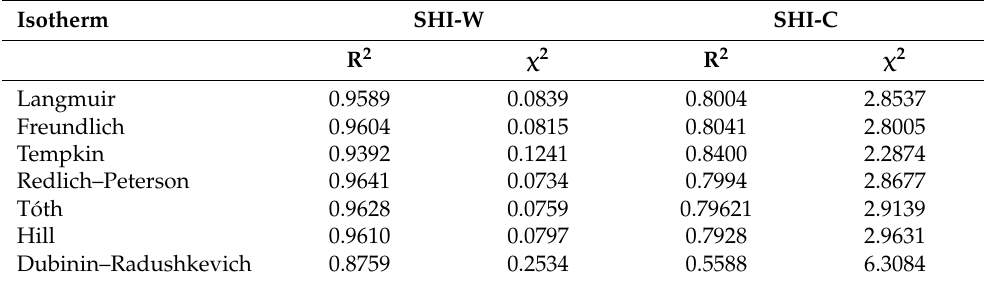
Table 4. Non-linear correlation coefficient R 2 and Chi-square χ 2 of isotherms models for copper adsorption onto washed (SHI-W) and Na 2 CO 3 activated (SHI-C) hemp shives. Isotherm SHI-W SHI-C R 2 χ 2 R 2 χ 2 Langmuir